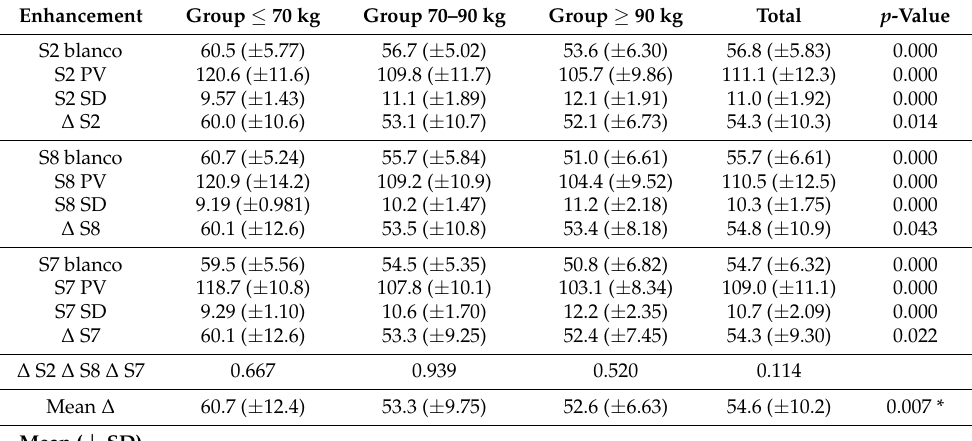
Table 2. Enhancement in liver segments for the weight groups.